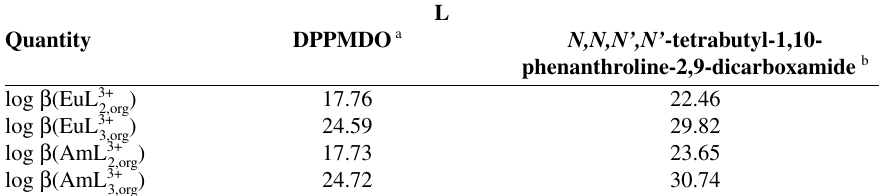
Table 7. Stability constants of the complexes ML 3+ butyl-1,10-phenanthroline-2,9-dicarboxamide, bis(diphenylphosphino)methane dioxide (DPPMDO) – see Scheme 2) in nitrobenzene saturated with water at 25